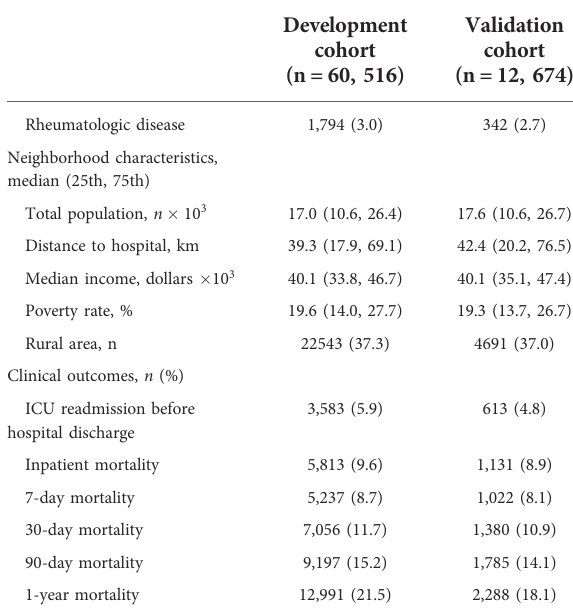
TABLE 1 Summary statistics for experimental ICU